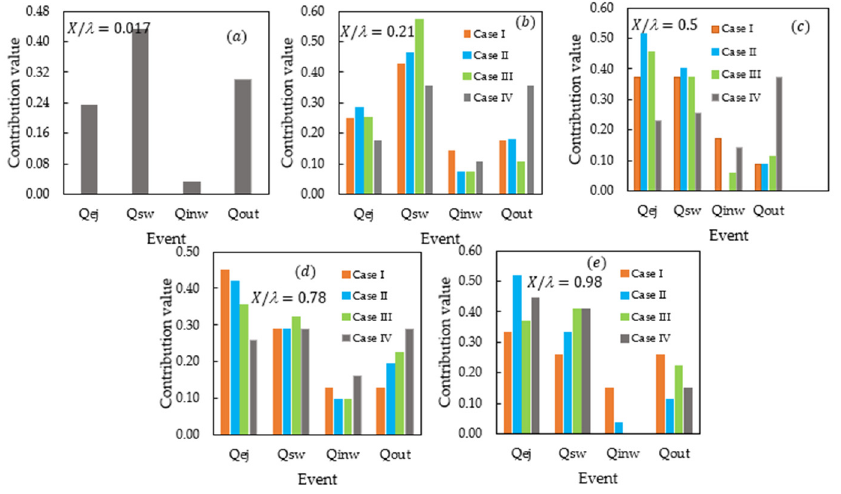
Figure 8. Quadrant analysis using the bursting cycle detection method at ( a ) the upstream section of the pool ( X/ λ = 0.017 ), ( b ) the pool entrance ( X/ λ = 0.21 ), ( c ) the middle of the pool ( X/ λ = 0.5 ), ( d ) the pool exit ( X/ λ = 0.78 ), and ( e ) the downstream section of the pool ( X/ λ = 0.98 ) for all Cases .